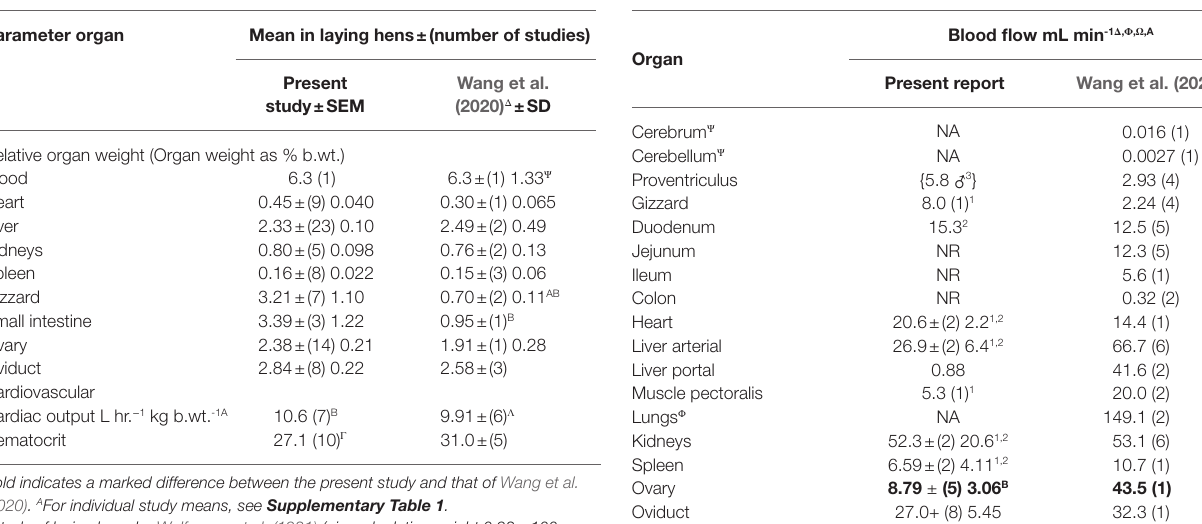
TABLE 7 | Comparison of organ weights, cardiac output and hematocrit in laying hens and those reported by Wang et al. (2020). Parameter organ Mean in laying hens ± (number of studies) Present study ± SEM